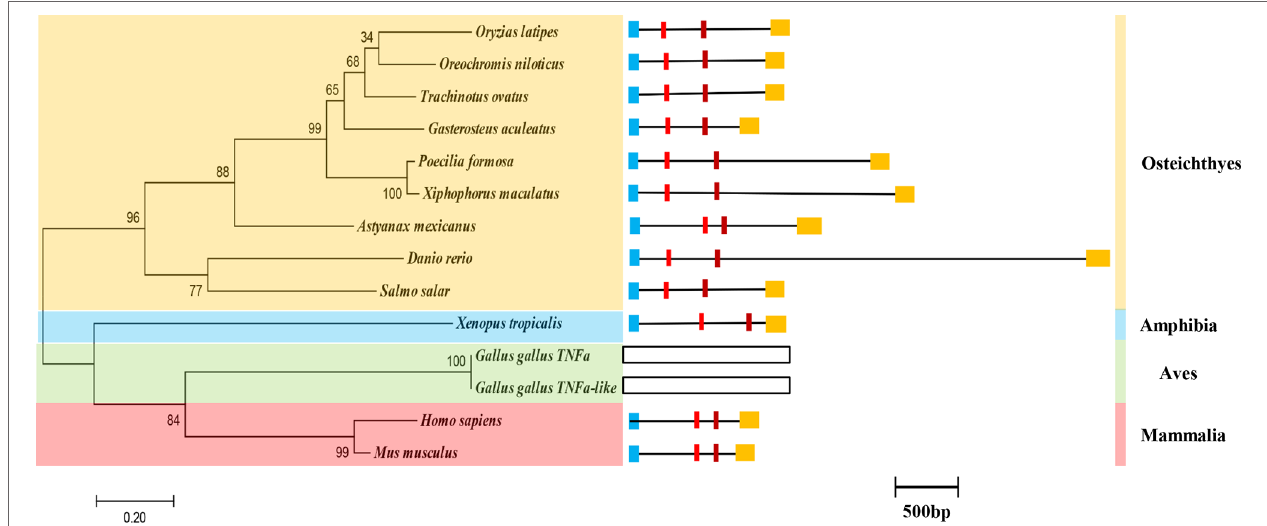
FIGURE 3 | The phylogenetic relationship and genome structure of the ToTNF α gene. Genome structure analysis of ToTNF α genes according to their phylogenetic relationship. Lengths of exons and introns of each TNF α gene are displayed proportionally. Different colour boxes and lines represent exons and introns, respectively. The identical colour boxes represent homologous